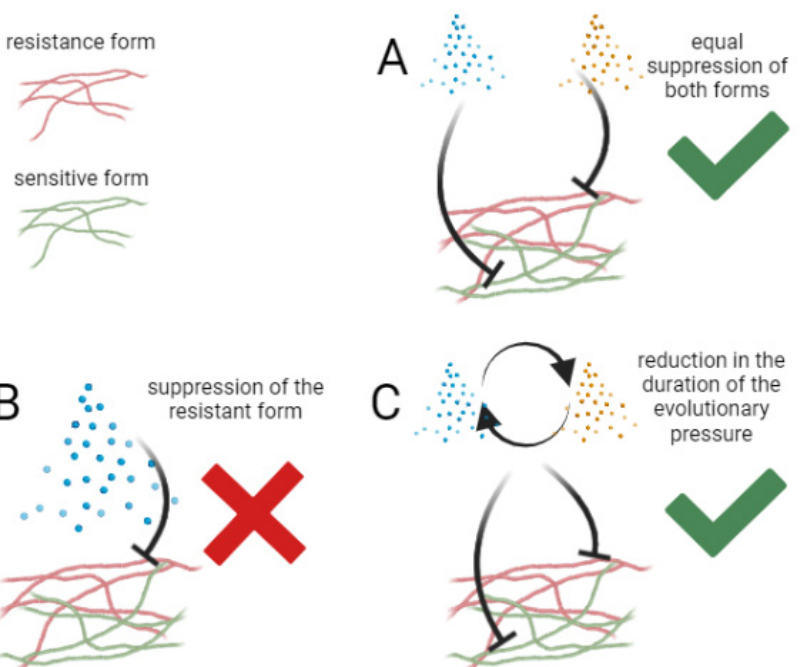
Figure 1. Three strategies for reducing the evolutionary pressure of fungicides on pathogens: ( A ) equal suppression of the growth of both forms; ( B ) suppression of the growth of the resistant forms compared to the sensitive ones; ( C ) and reduction in the duration of the evolutionary pressure.